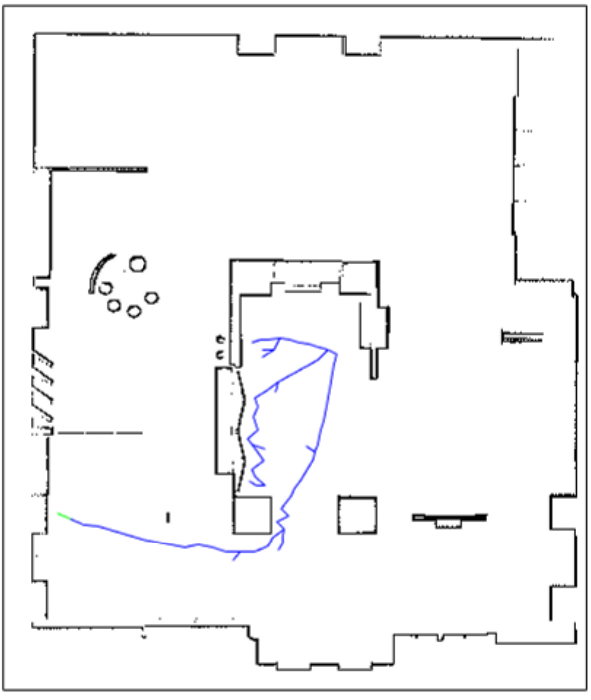
Figure 8. A simulation in a more complex